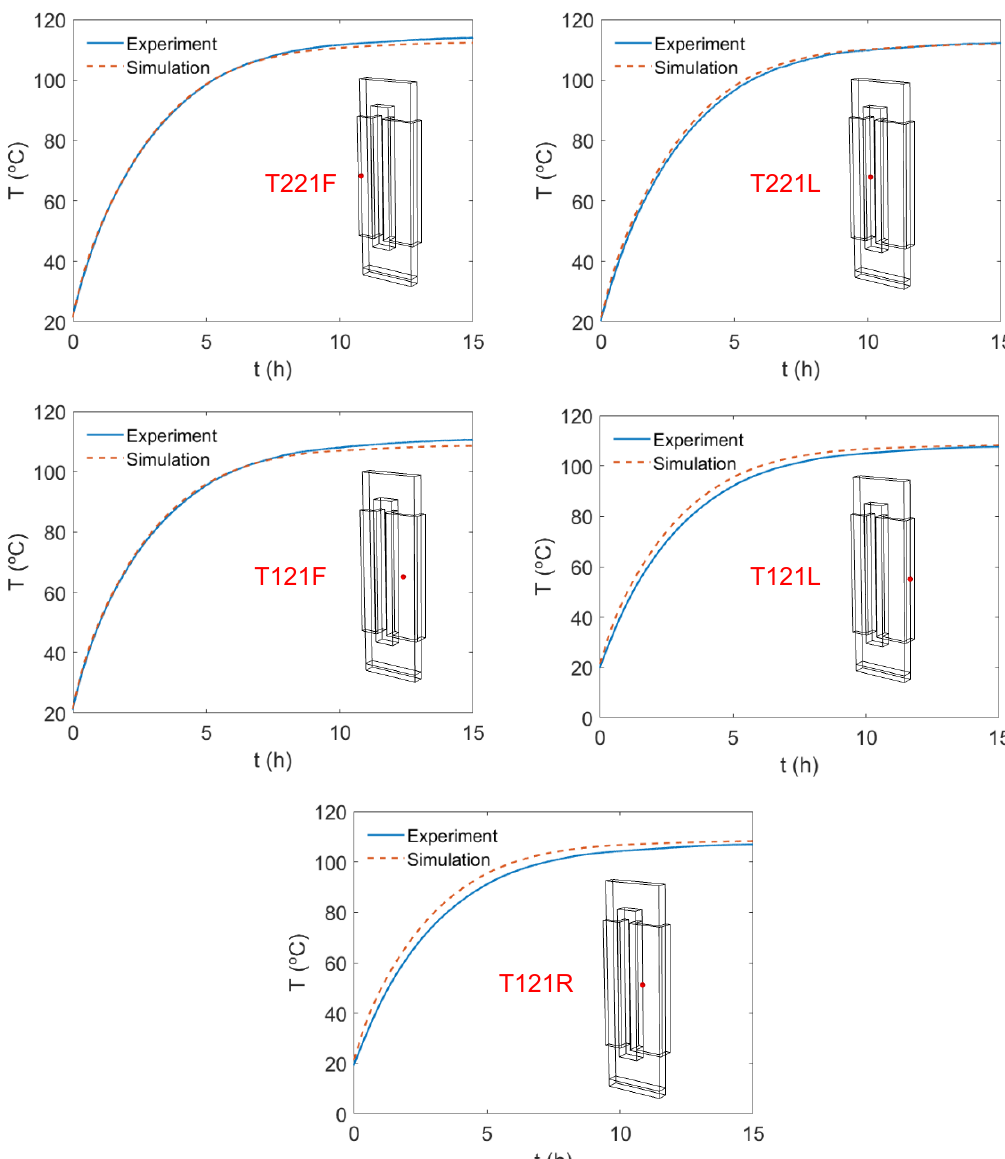
Figure 12. Time evolution of the temperature at different points of the transformer. Comparison between experiments and simulations. Case 6.